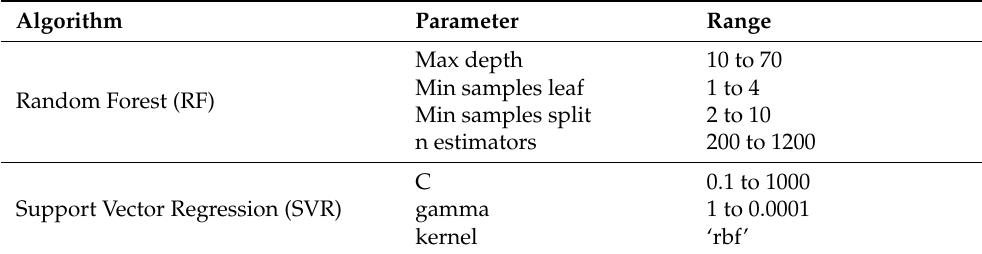
Table 1. Hyper-tunning